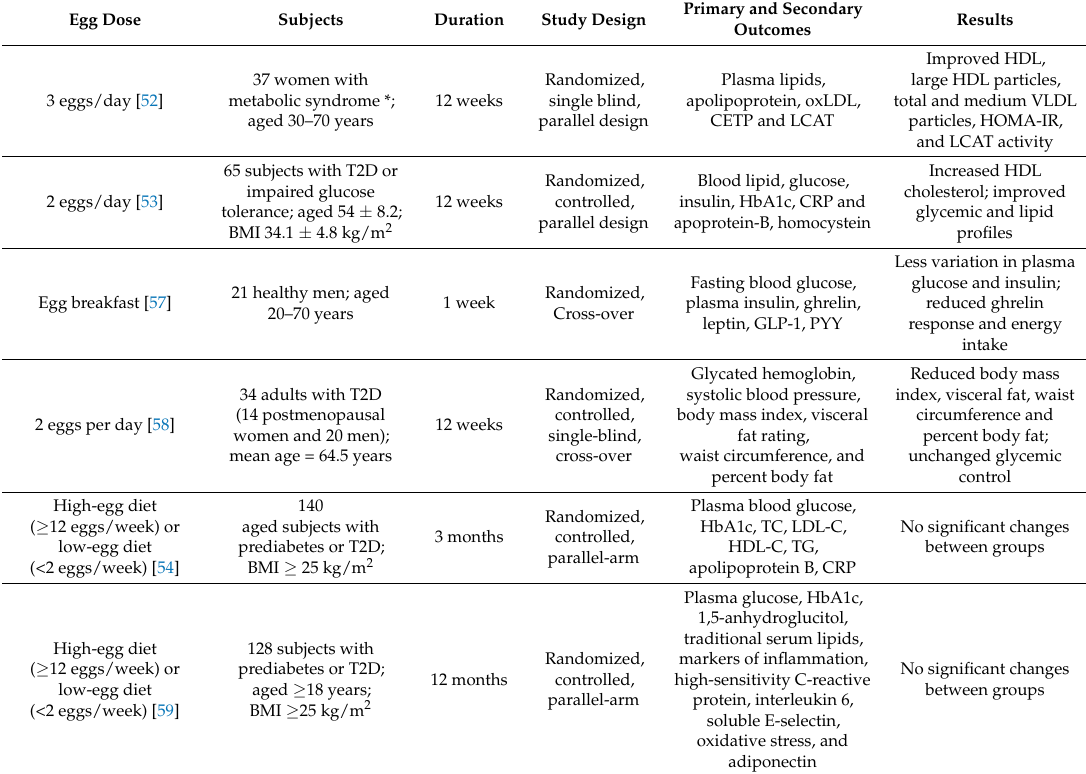
Table 1. Recent clinical studies investigating the effect of egg consumption on T2D Egg Dose Subjects